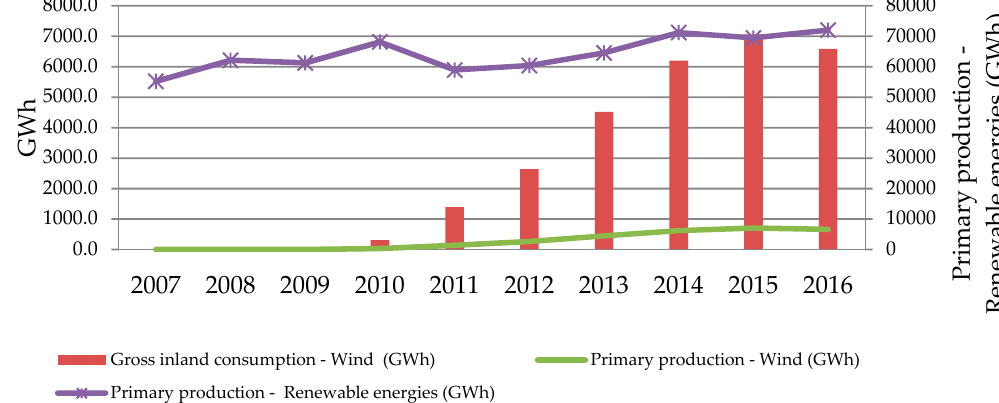
Figure 12. Main wind indicators evolution between 2007 and 2016, Source: Own research based on Eurostat data [12].